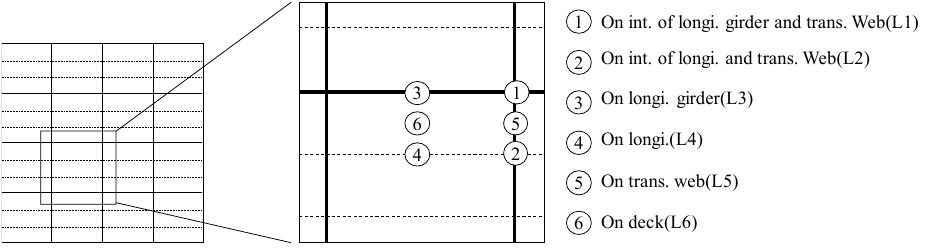
Figure 9. Assumed locations of the D-Rings.